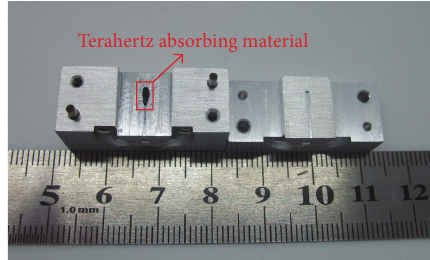
Figure 5: The text fixture with the THz absorbing material.